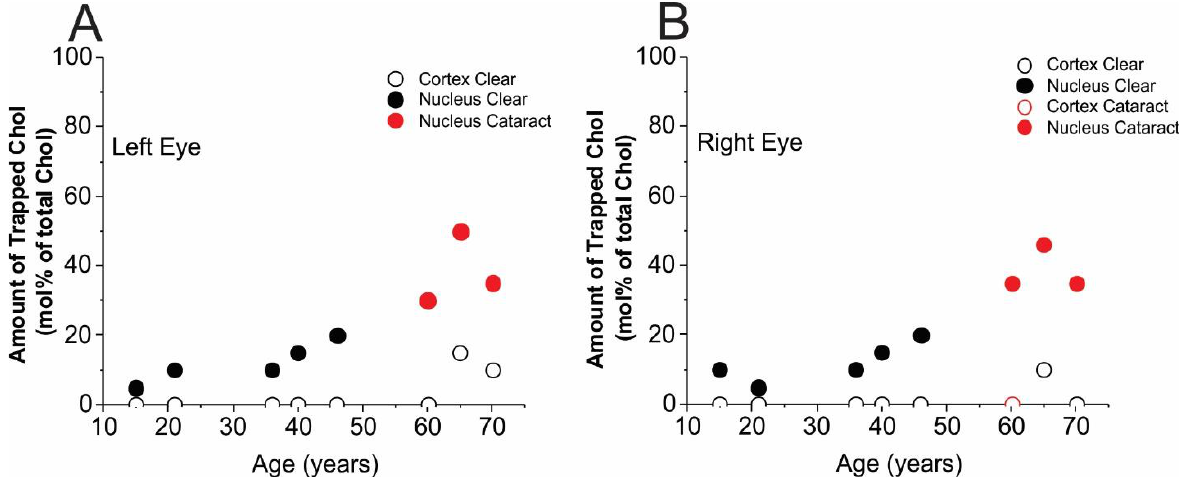
Figure 5. Amounts of trapped Chol (mol% of total Chol in domains uniquely formed due to the presence of membrane proteins) in single, intact, human cortical ( ○ ), and nuclear (●) lens membranes. Data obtained from the left eye lenses ( A ) and right eye lenses ( B ) are included. Both the left and right eyes of donors aged 60, 65, and 70 years have nuclear cataracts ( ● ) and only the right eye of the 60-year-old donor has a cortical cataract ( ○ ).